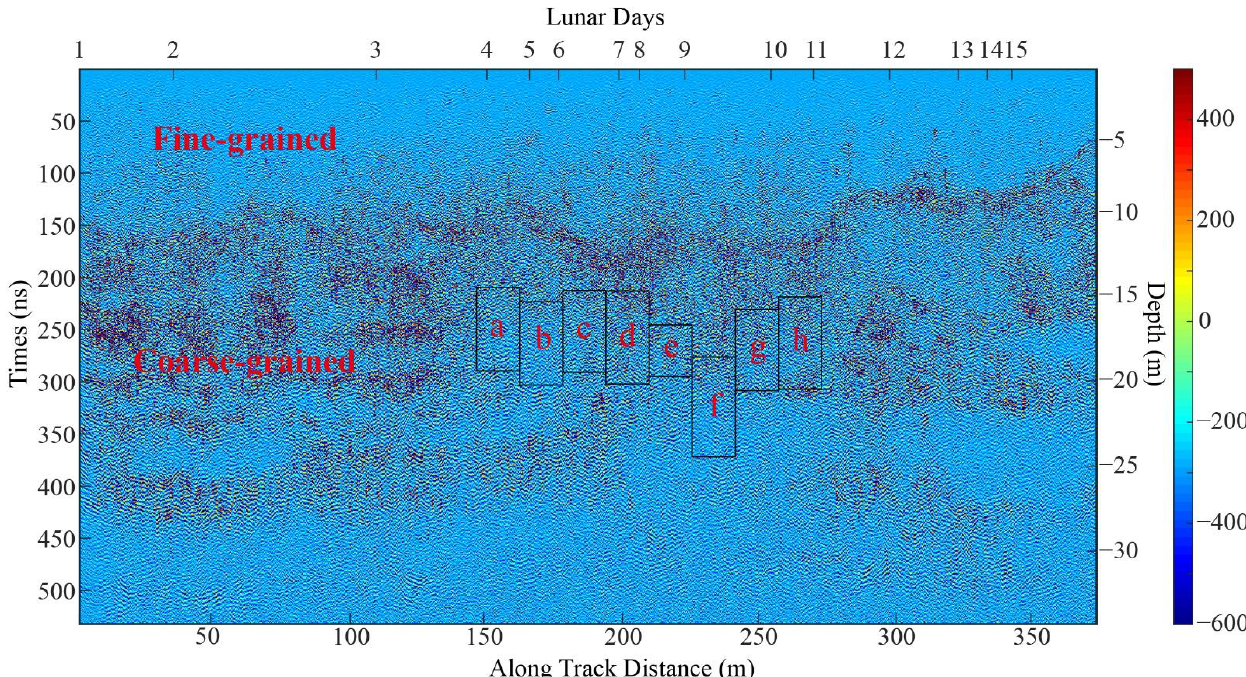
Remote Sens. 2021 , 13 , x FOR PEER REVIEW Figure 6. The first fifteen lunar days’ LPR data image after processing. The color bar is the amplitude of the LPR signal after processing. Groups a-g indicate the areas used to calculate the loss tangent.